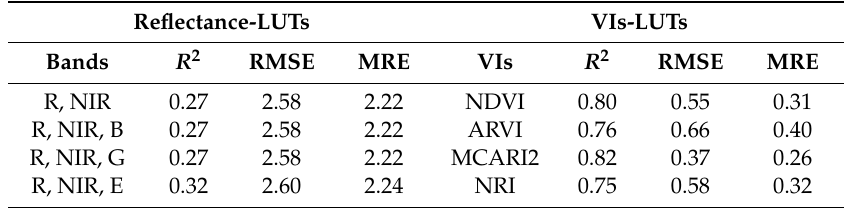
Table 11. R 2 , RMSE, and MRE for linear regression between simulated LAI and estimated LAI based on reflectance-LUTs / VI-LUTs using hyperspectral UAV data in 2018 (n =